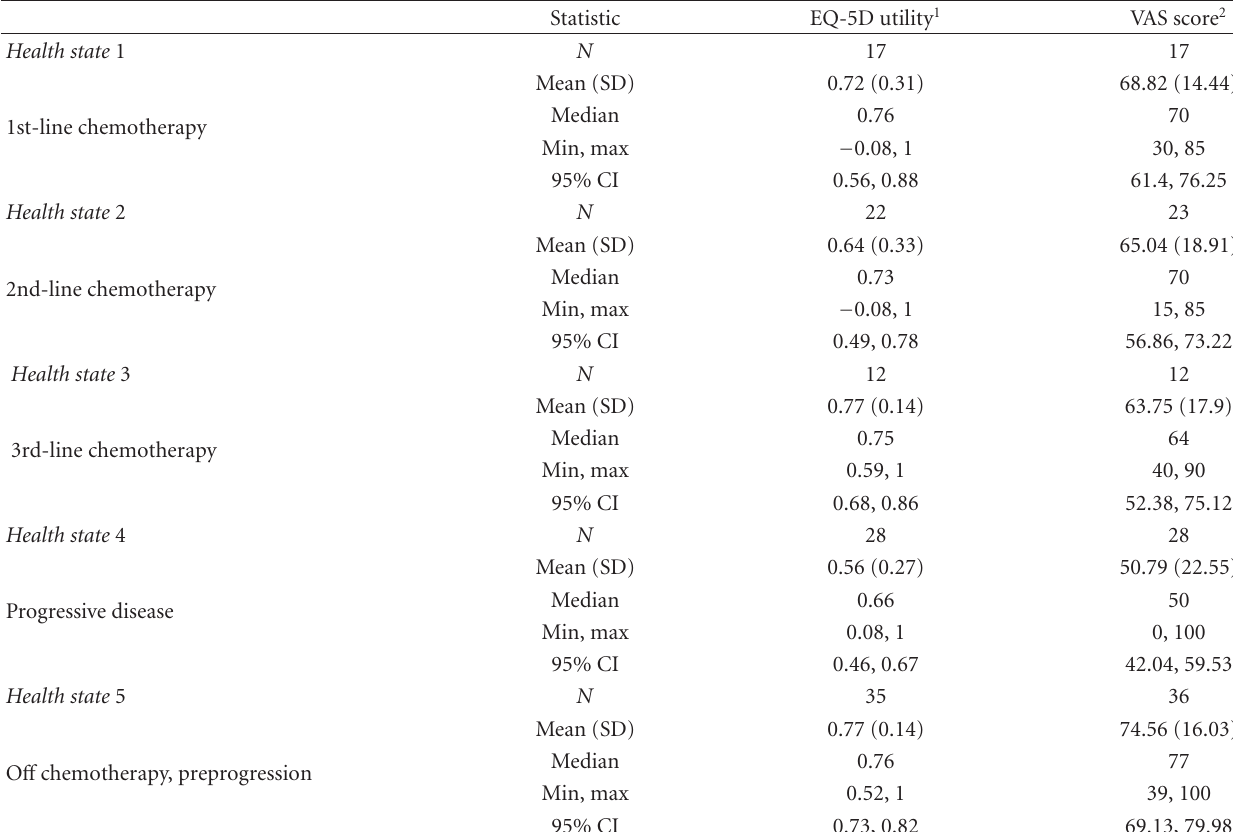
Table 4: EQ-5D utility values and VAS scores by health